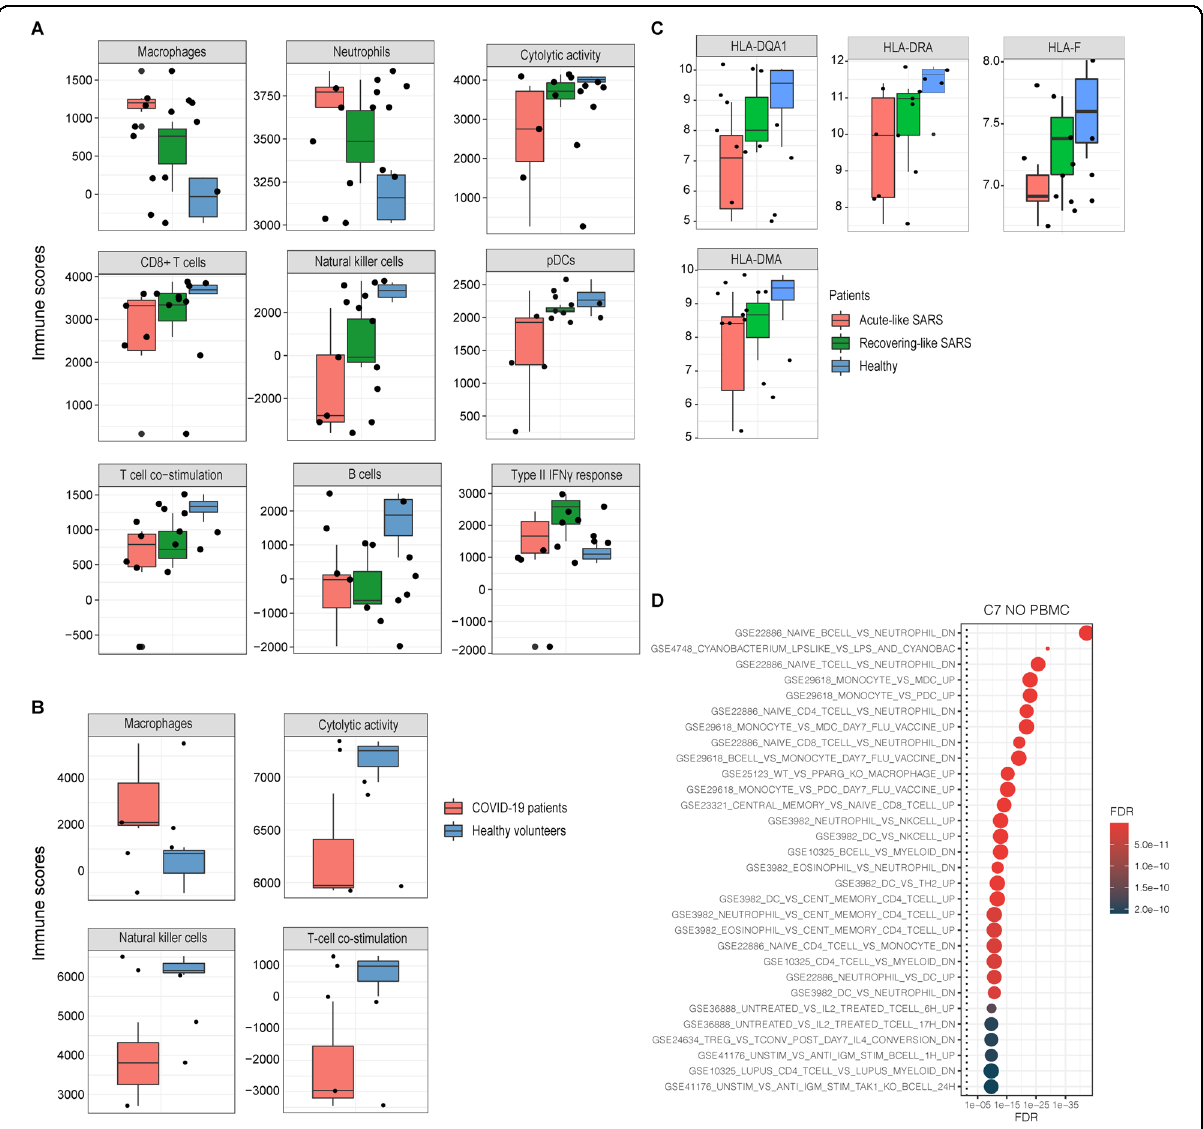
Fig. 5 Immune cells, their activities and HLA types in progression stage-speci fi c coronavirus-infected patients. A , B Immune cell scores using ssGSEA analysis and speci fi c immune signature from Rooney et al. representing speci fi c immune cells and their activities in acute-like ( n = 7), and recovering-like ( n = 3) SARS patients and control healthy individuals ( n = 4) ( A ), and COVID-19 patients and control healthy individuals ( B ). FDR for A and B are <0.2. C HLA pro fi les in acute-like, and recovering-like SARS patients and control healthy individuals. Kruskal – Wallis statistical nominal p values for HLA-DQA1 and HLA-DOB are <0.1 and HLA-F is <0.05. Multiple testing correction was not performed due to small sample size for C (the intention of the study is to infer from publicly available limited data). D . Enrichment analysis (hypergeometric test using hypeR 57 ) of CoV-Up-gene signature using MSigDB ’ s C7 immune gensets 20